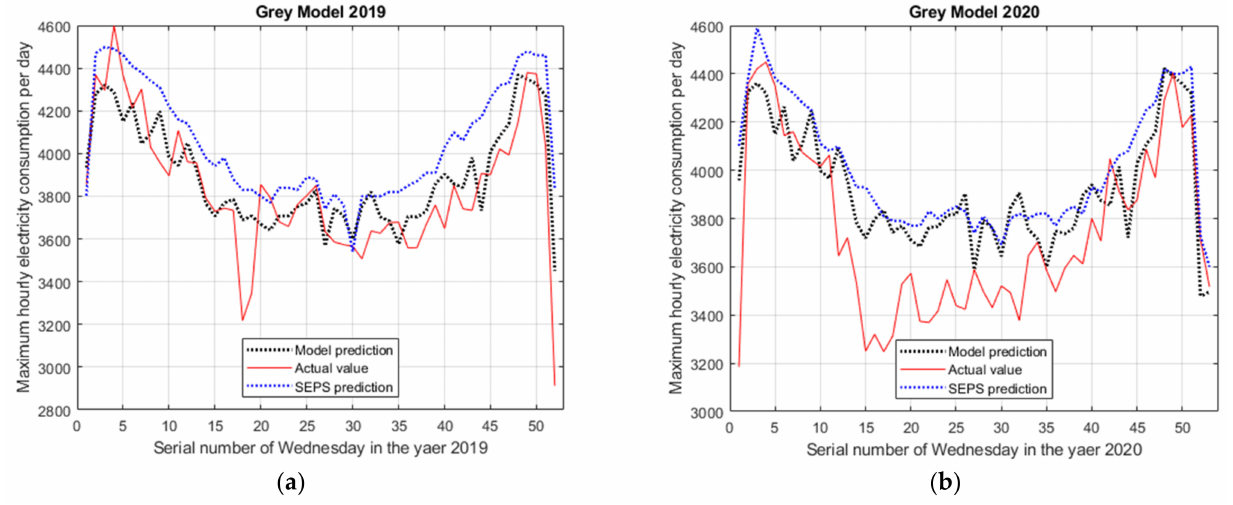
Figure 6. Prediction of Grey Model set. ( a ) Prediction of GM(1,1) set for 2019, ( b ) Prediction of GM(1,1) set for 2020.